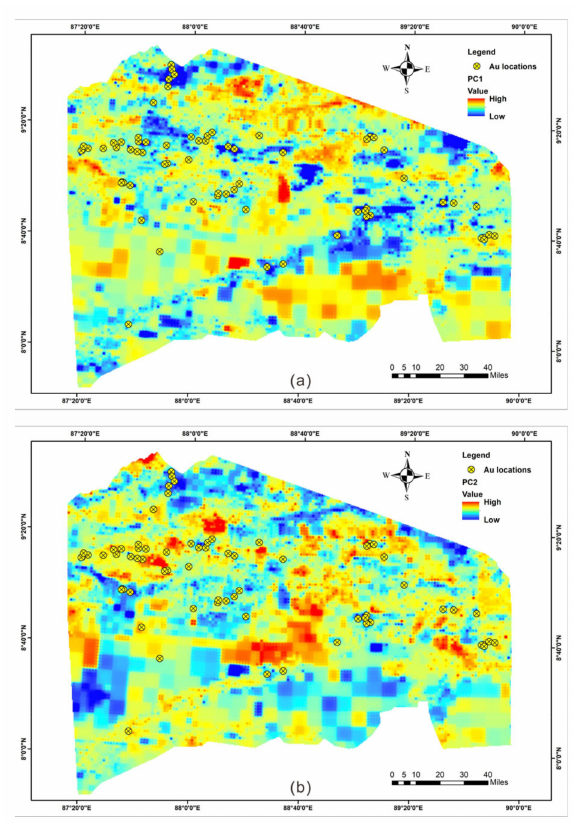
Figure 4. Geochemical images of robust principal component analysis. ( a ) PC1; ( b )